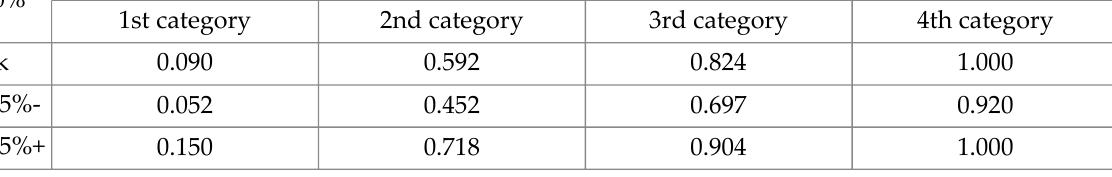
Figure 3. Probability of developing bronchopulmonary dysplasia for particular risk categories.